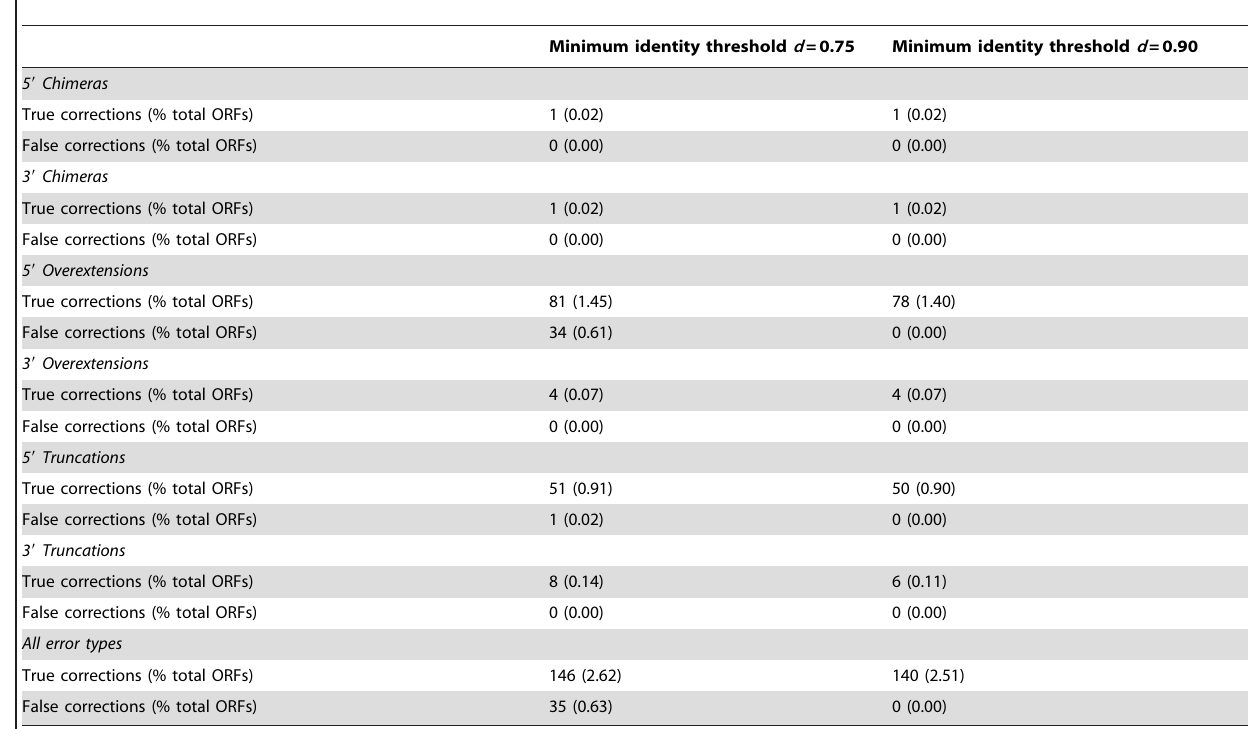
Table 2. Performance of ORFcor on 123 complete genome sequences belonging to the Enterobacteriaceae using default settings, except as